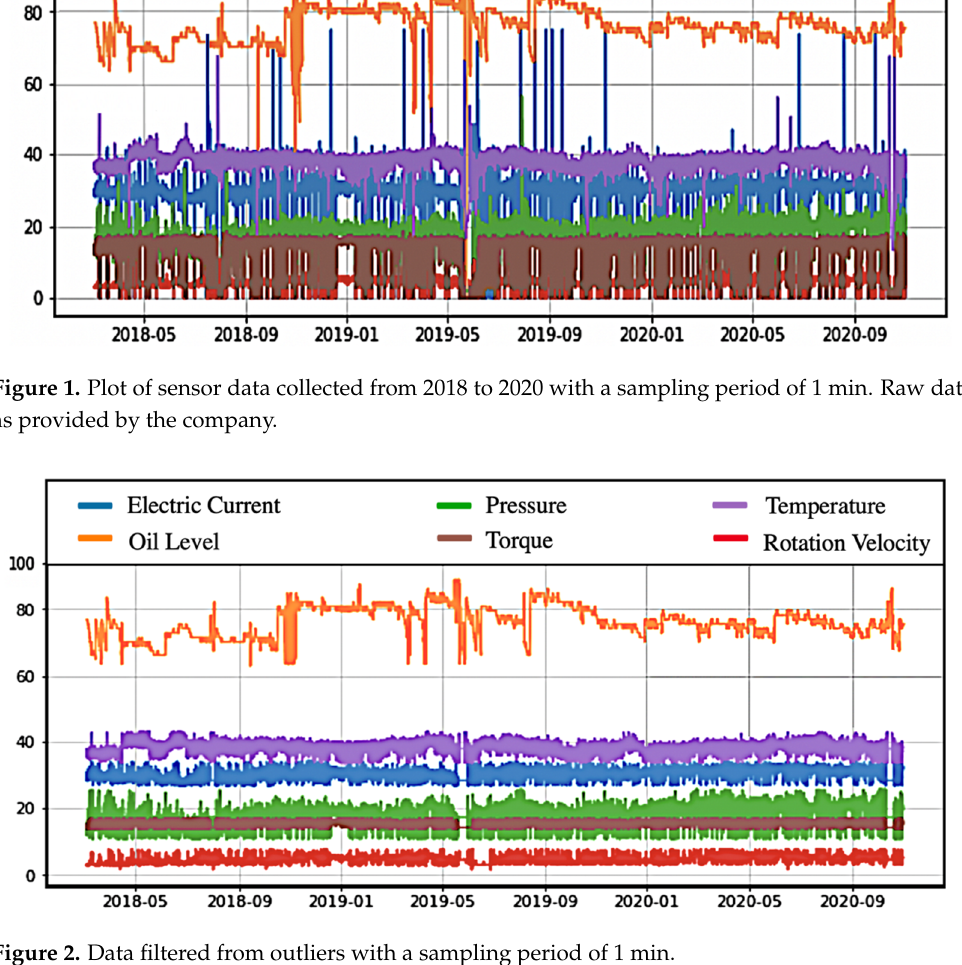
Figure 2. Data filtered from outliers with a sampling period of 1 min.